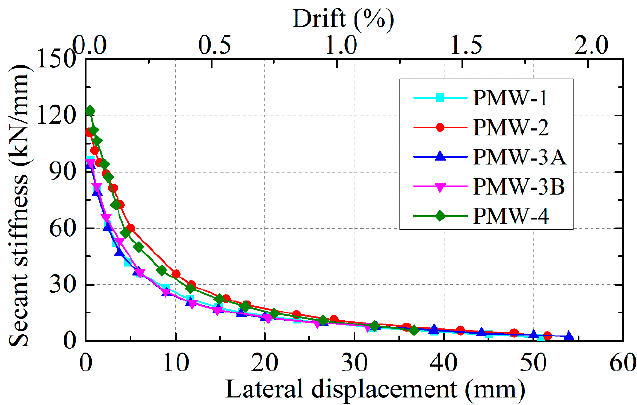
Figure 12. Evolution of stiffness degradation of test walls.